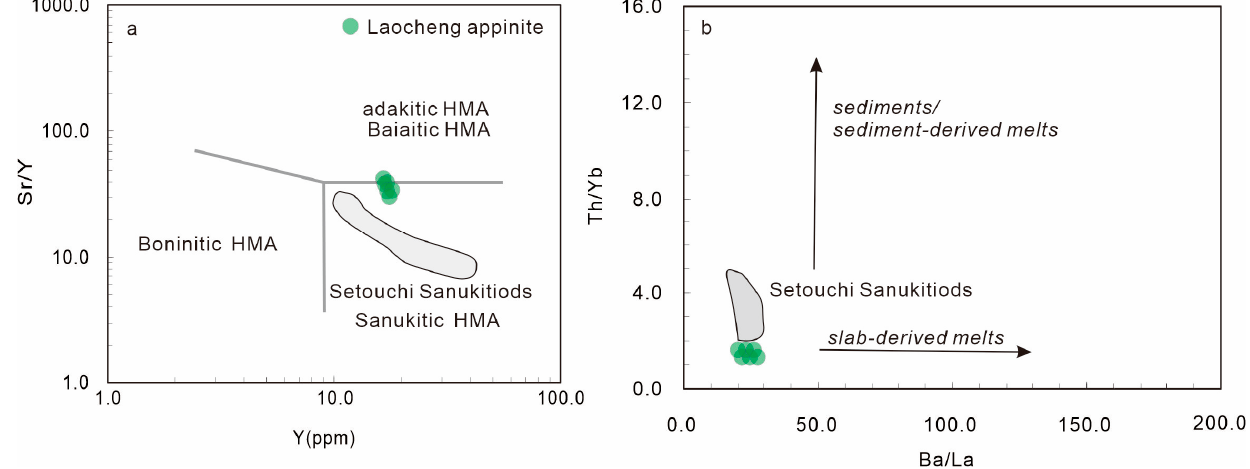
Figure 9. Y vs. Sr/Y ( a ) and Ba/La vs. Th/Yb ( b ) discrimination diagrams (after Tatsumi, 2006) for the Laocheng appinite [24].